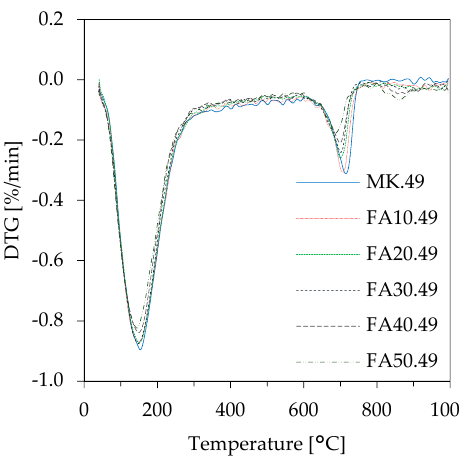
Figure 12. Differential thermogravimetric ( DTG) curves of geopolymers (l/s 0.49).